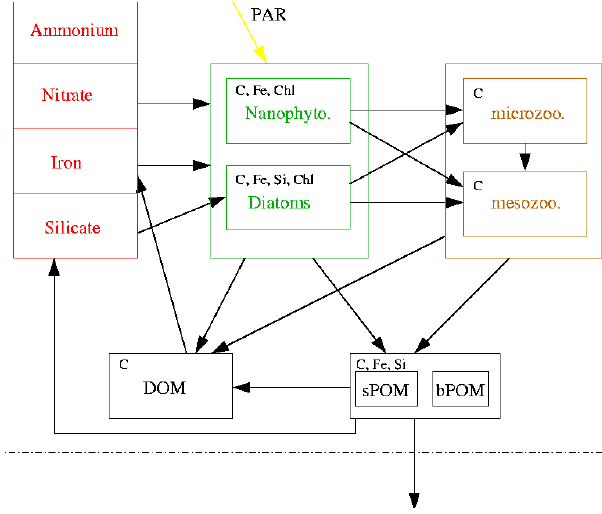
Figure 1. Architecture of PISCES. This figure only shows the ecosystem model omitting thus oxygen and the carbonate system. The elements which are explicitly modeled are indicated in the left corner of each